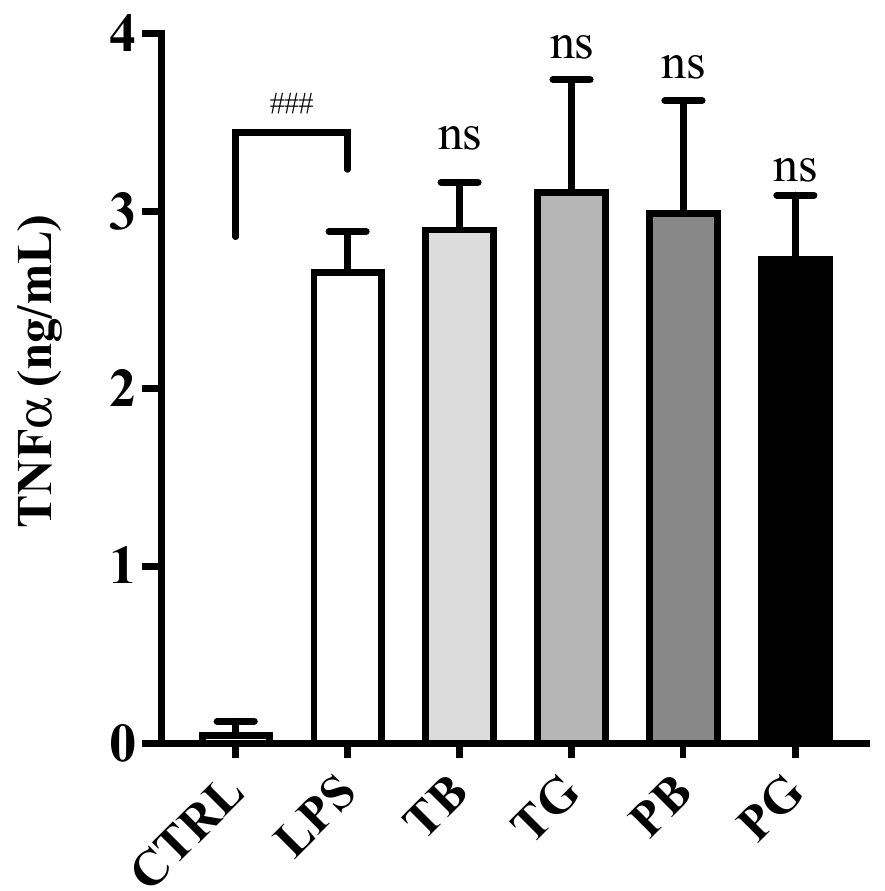
Figure 6. Effects of various tea treatments on TNF- α secretion in LPS-stimulated macrophages as the inflammatory model. LPS (0.5 µ g/mL) was added to all groups at time 0 h for 24 h until assay, except the control group. In the LPS-stimulated macrophages, the cells were incubated in the medium without/with tea samples (0.5 mg/mL). The data were presented as mean ± SE of three experiments. ### p < 0.001 vs. control; ns p > 0.05 vs. LPS. LPS: Lipopolysaccharide; T: Taiwan Tea Experiment Station No. 12; P: purple shoot tea; G: green tea and B: black tea. TNF- α , tumor necrosis factor- α .